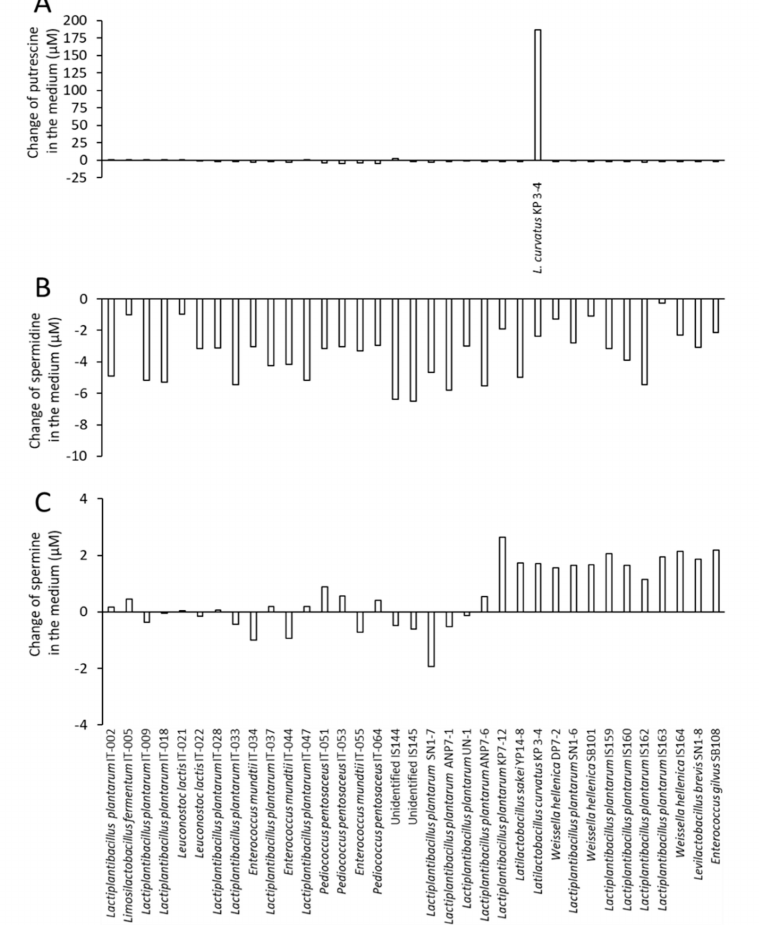
Figure 1. Concentration of polyamines in culture supernatants of bacteria isolated from food. Bacteria were isolated from food and cultured in MRS medium anaerobically for 2 days at 37 ◦ C. Concentration of putrescine ( A ), spermidine ( B ), and spermine ( C ) in the culture supernatant was analyzed by HPLC ( n = 1). The values are shown as changes in the amount of polyamine from the MRS medium to the culture